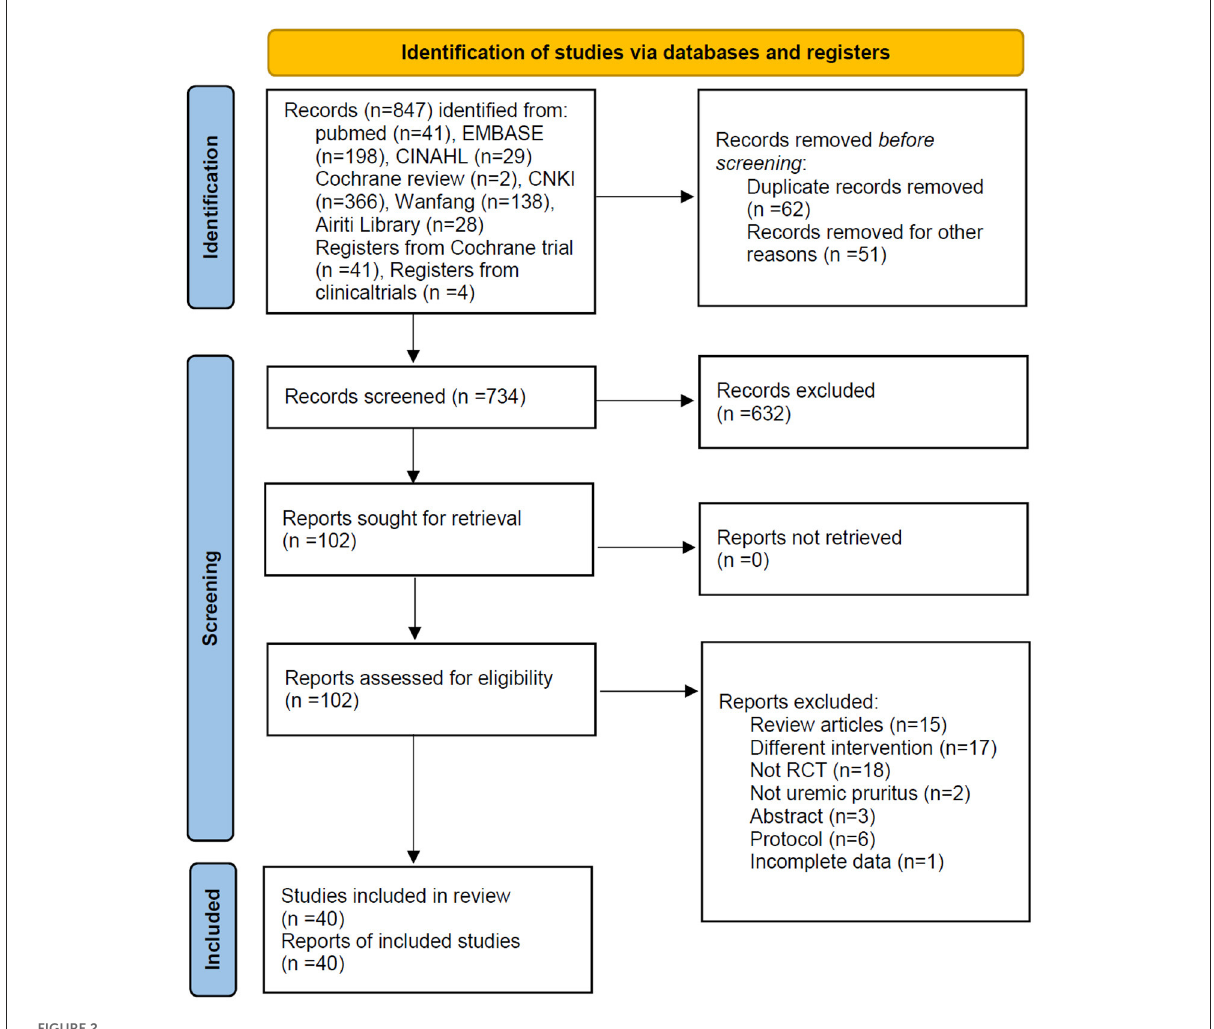
FIGURE2 Risk of bias in the selected